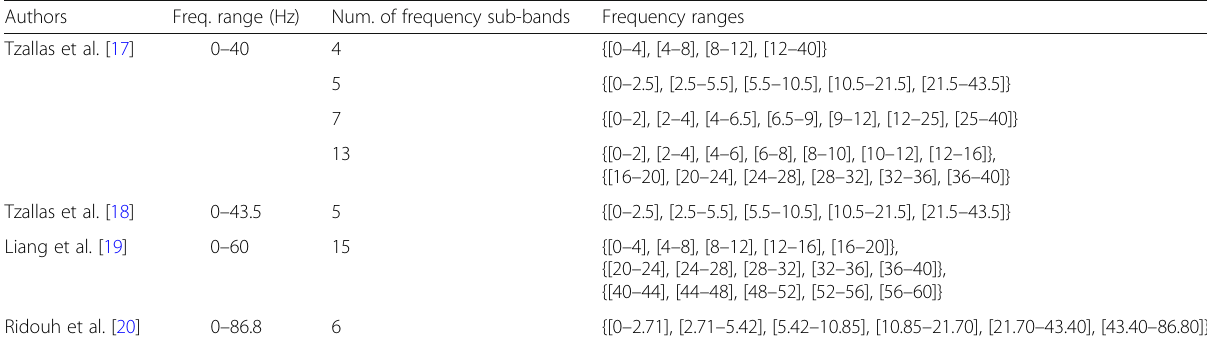
Table 2 TFD-based methods for EEG analysis